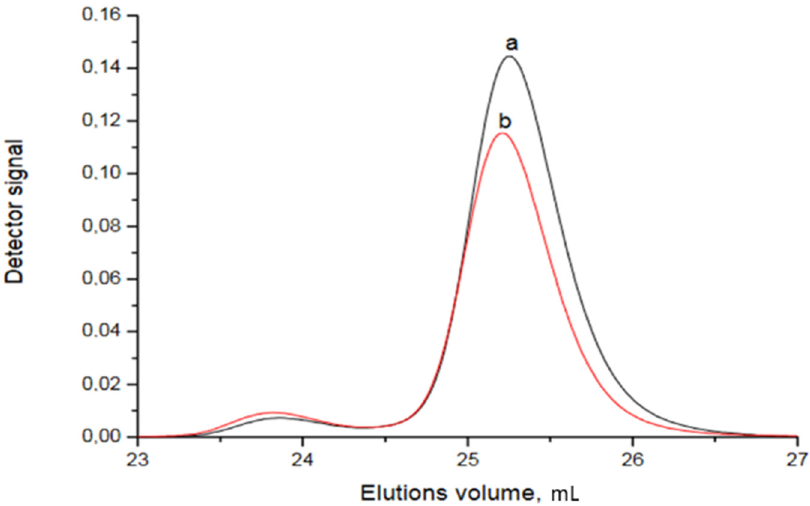
Figure 10. SEC elugram of Sample R2: (a) macroinitiator; (b) diblock-copolymer.